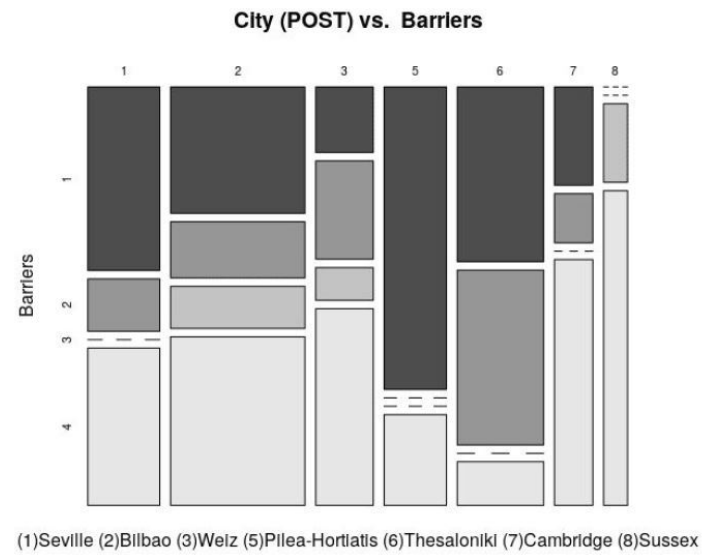
Figure 9. POST-pilot: Comparison of the distribution of barriers in each pilot. Y axis: Absentmindedness (1), Lack of Awareness (2), Discouragement from Peers (3) and Another Reason